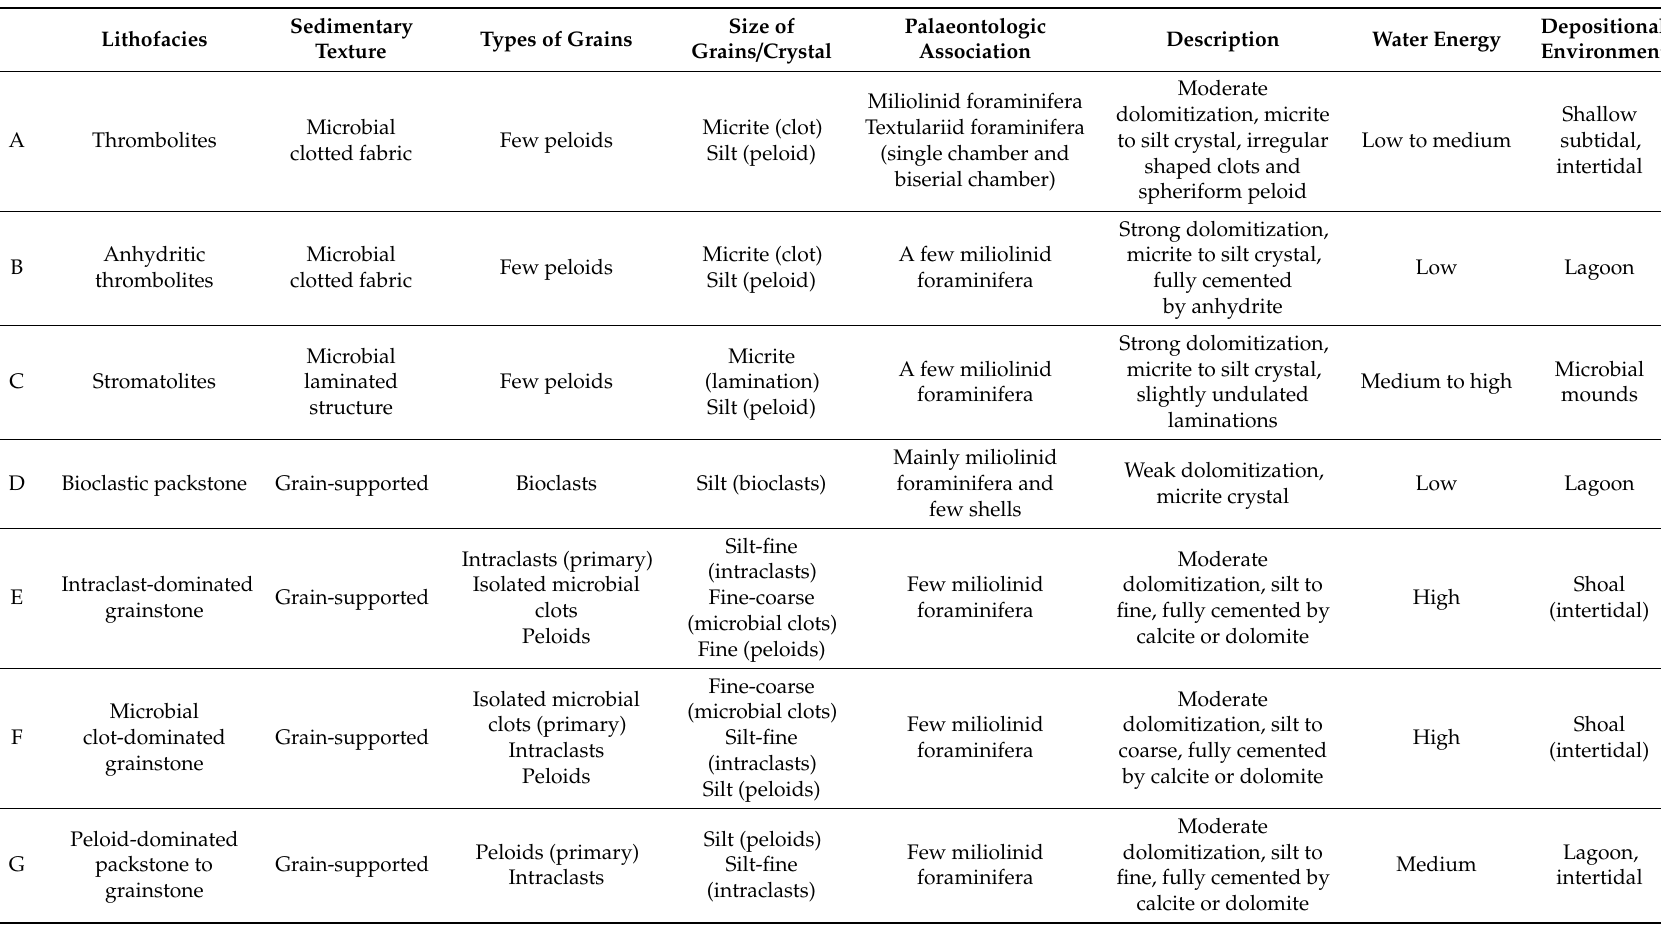
Table 1. Lithofacies types of the fourth member of the Leikoupo Formation in the Western Sichuan